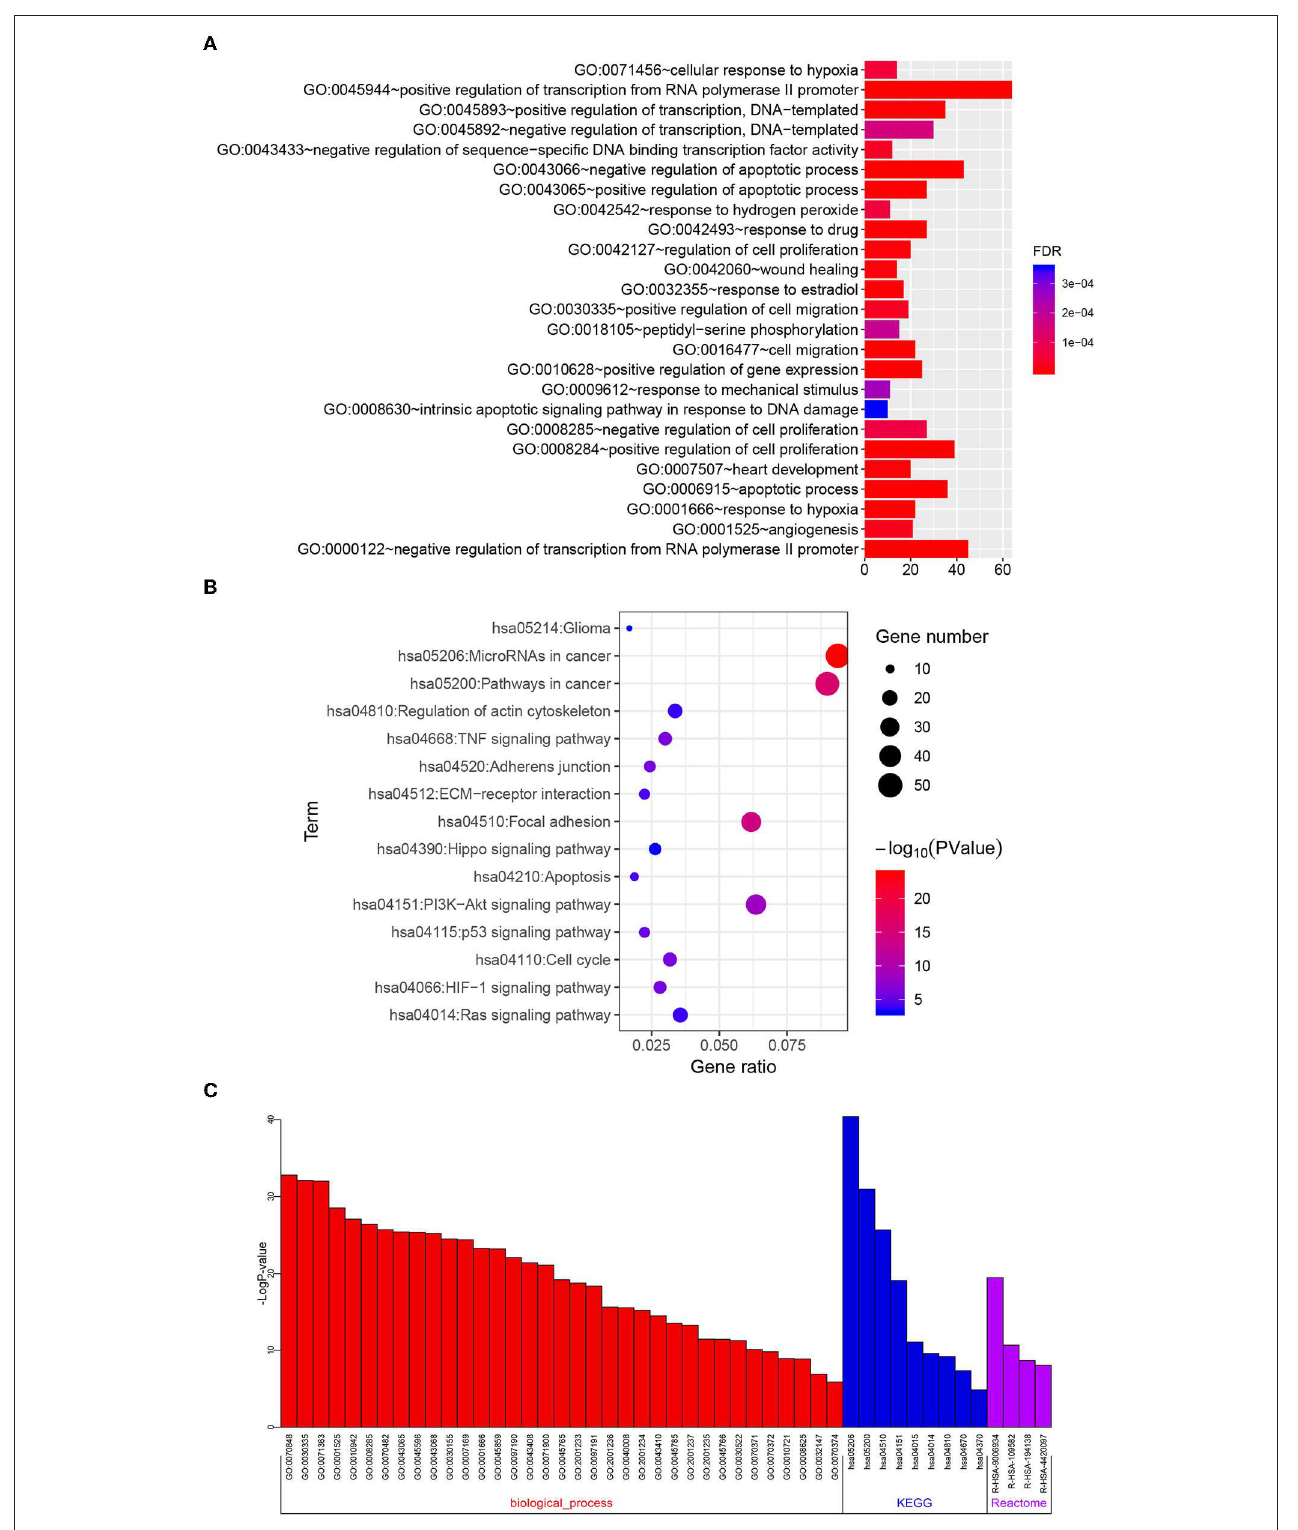
FIGURE 9 | Functional roles of the six-pseudogene risk signature. Gene oncology (A) and KEGG pathway (B) analyses were performed on the related target genes via DAVID. (C) Metascape was used to confirm the functional and pathway analysis in biological processes, KEGG, and Reactome pathways.